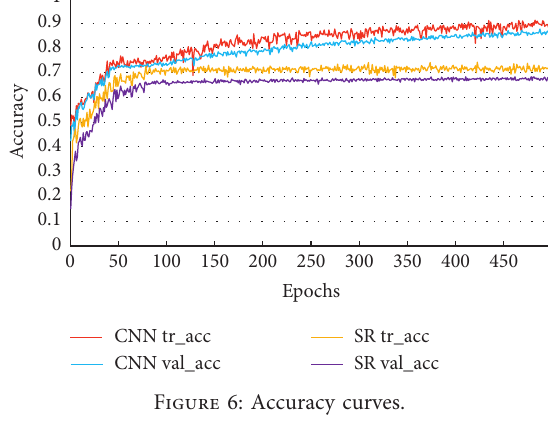
Figure 6: Accuracy curves.